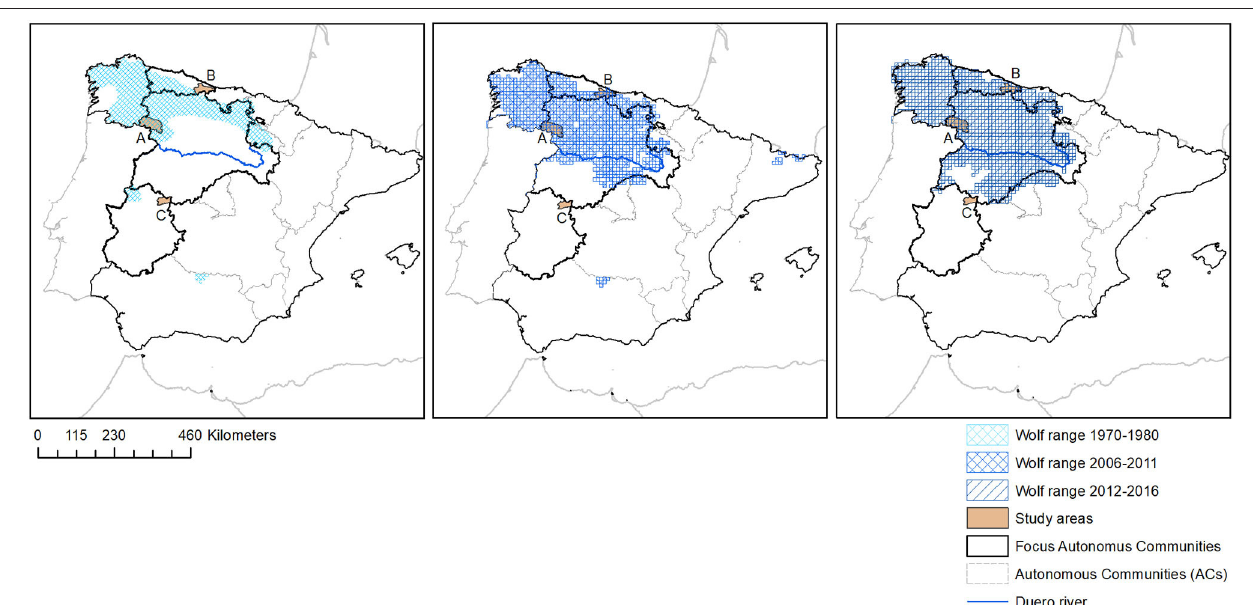
FIGURE 2 | Iberian wolf expansion from the 1970s until the present, and its relation to the study locations (A–C) (Data sources: Valverde, 1971; Chapron et al., 2014; Linnell and Cretois, 2018 ).